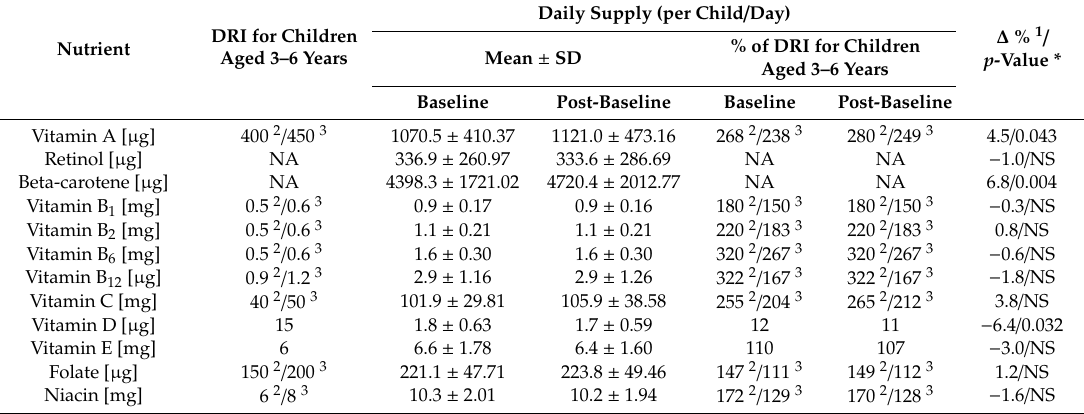
Table 2. The content of vitamins (per a child a day) in 231 preschools’ 10-day menus with reference to the age-specific dietary reference intake (DRI) before (baseline) and after (post-baseline) the education